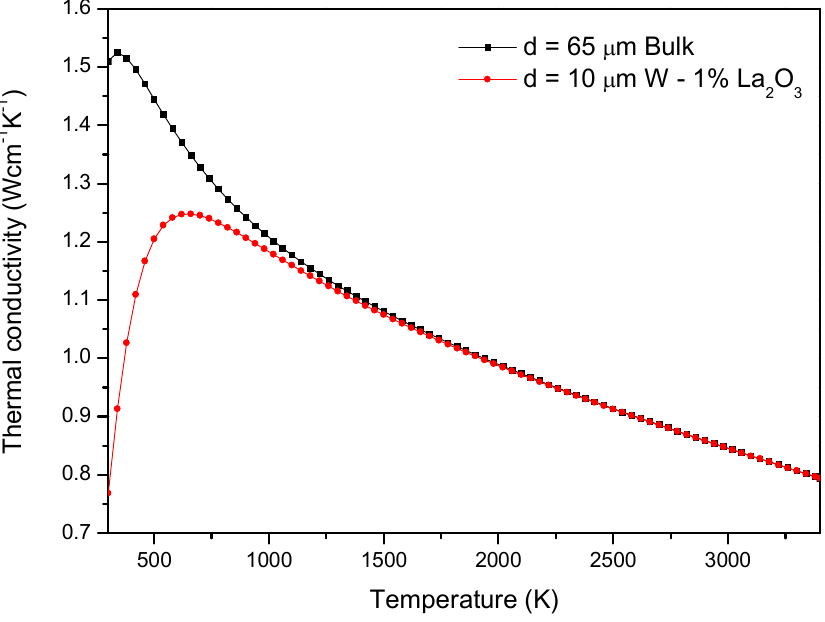
Figure 10. Thermal conductivity of W and W-1% La 2 O 3 vs. temperature calculated through Equations (1) and (2).